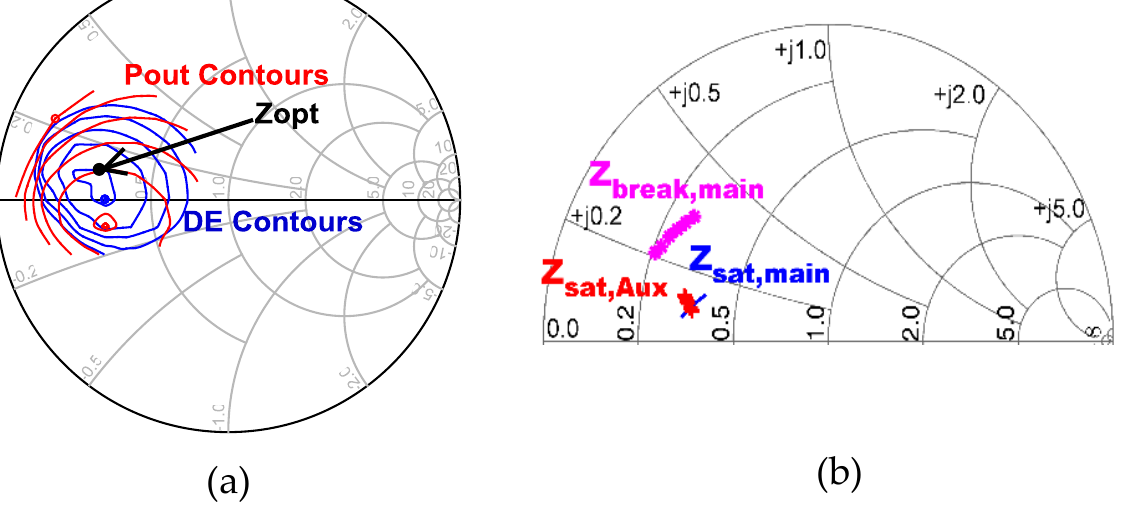
Figure 4. ( a ) Load-pull contours for the drain efficiency (blue) and output power (red) at 3.3GHz and ( b ) optimum output impedance at saturation and Output power Back-Off (OBO). DE, Drain